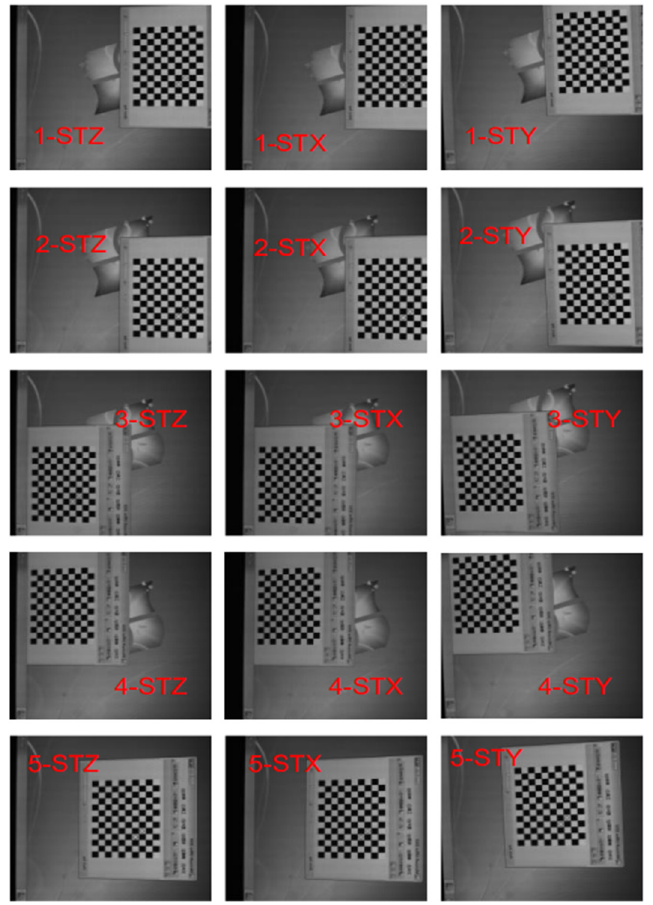
Figure 6. Checkerboard mirror image taken by the camera for calibration. The calibration grid moves on the reference plane five times. We change the position of the plane mirror to position STX, STY, and STZ for each grid. Then, we can obtain 5 × 3 = 15 calibration